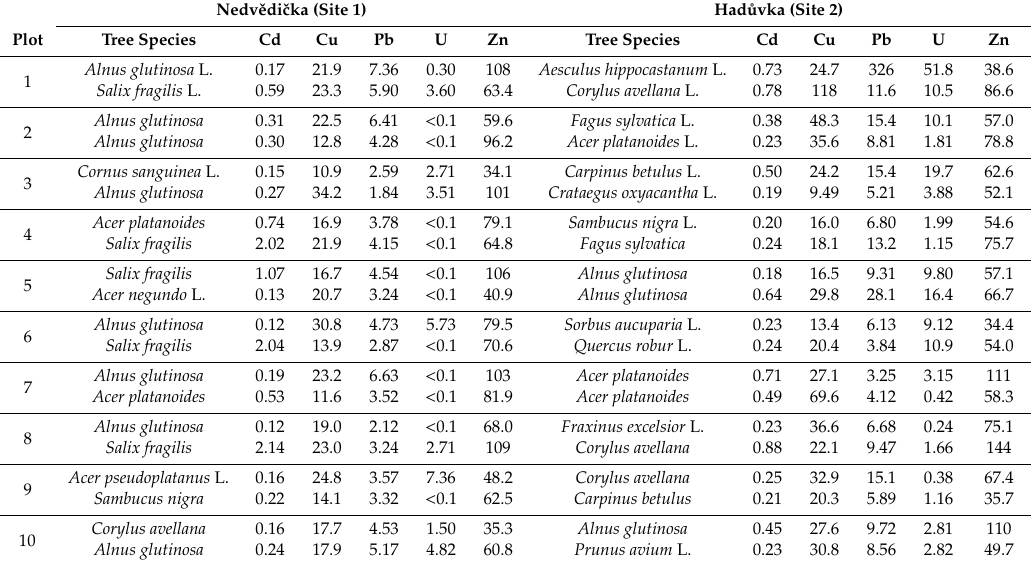
Table 1. Heavy Metal and Uranium Content (mg / kg DA) in the Leaves of the Riparian Forest Stands. Nedvˇediˇcka (Site